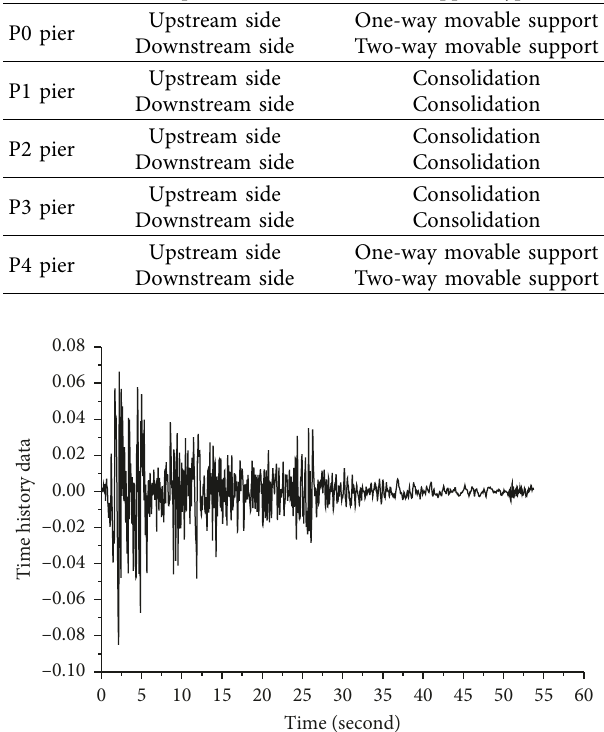
Figure 3: Time-history function of El Cento seismic wave after